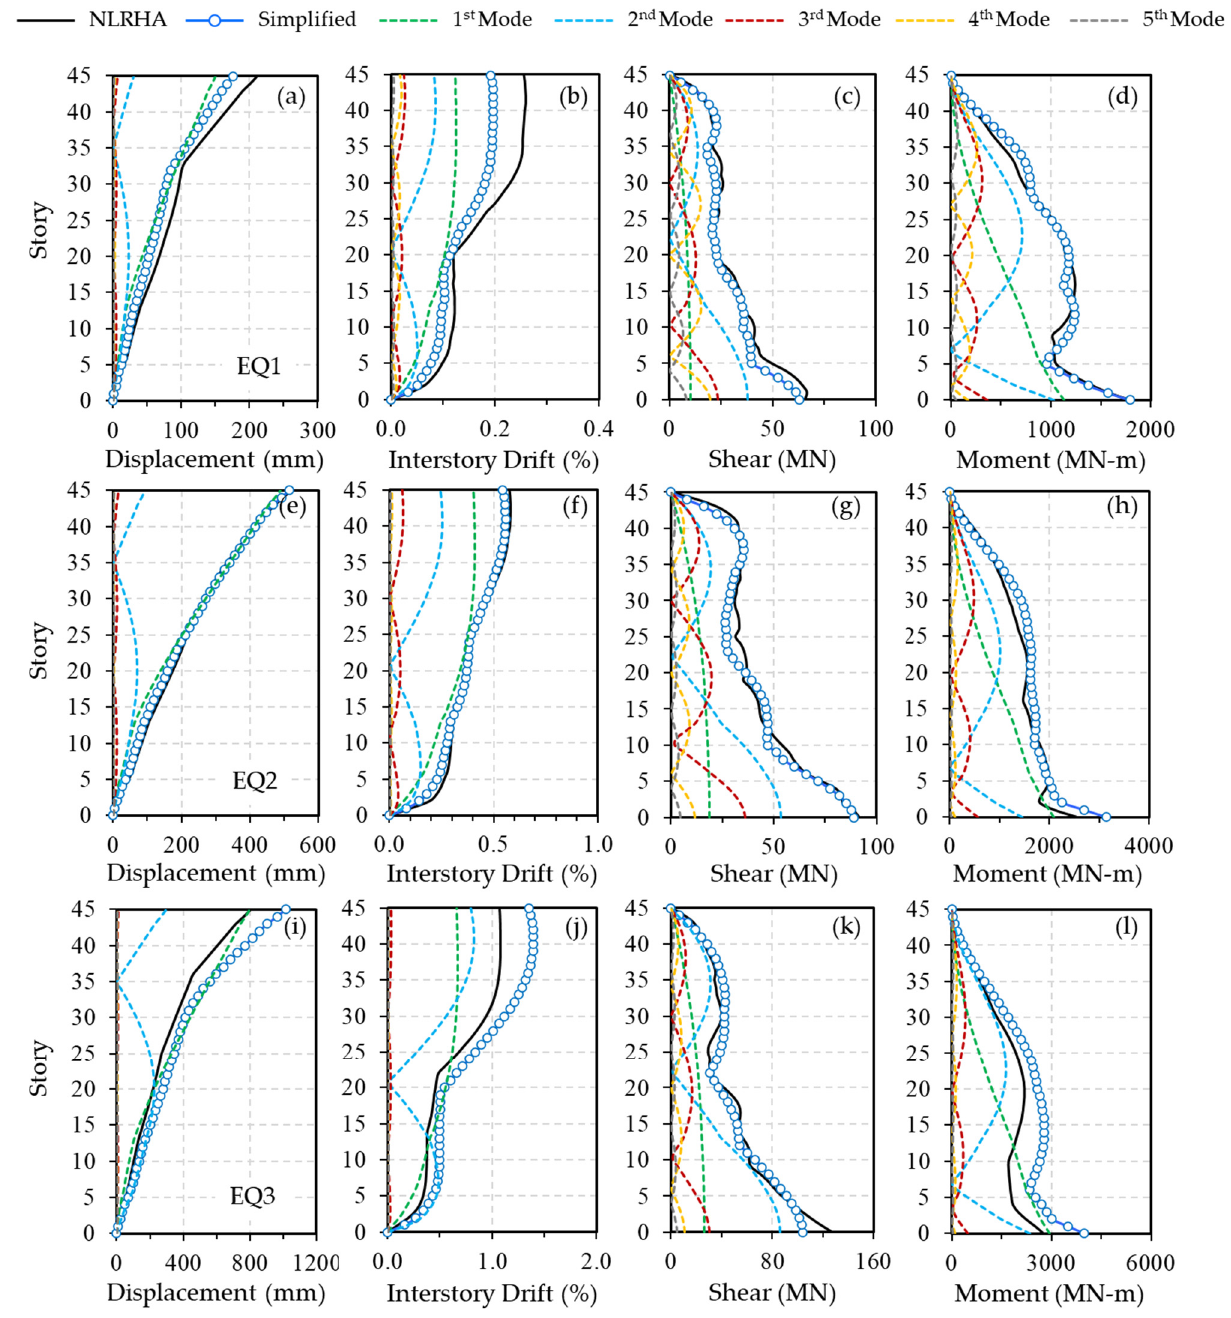
Figure 17. Comparison between various responses of the simplified and NLRHA procedures for all ground motion of building B3 in the x axis ( a ) Floor displacement under EQ1, ( b ) Interstory drift under EQ1, ( c ) Story shear under EQ1, ( d ) Story overturning moment under EQ1, ( e ) Floor displacement under EQ2, ( f ) Interstory drift under EQ2, ( g ) Story shear under EQ2, ( h ) Story overturning moment under EQ2, ( i ) Floor displacement under EQ3, ( j ) Interstory drift under EQ3, ( k ) Story shear under EQ3, ( l ) Story overturning moment under